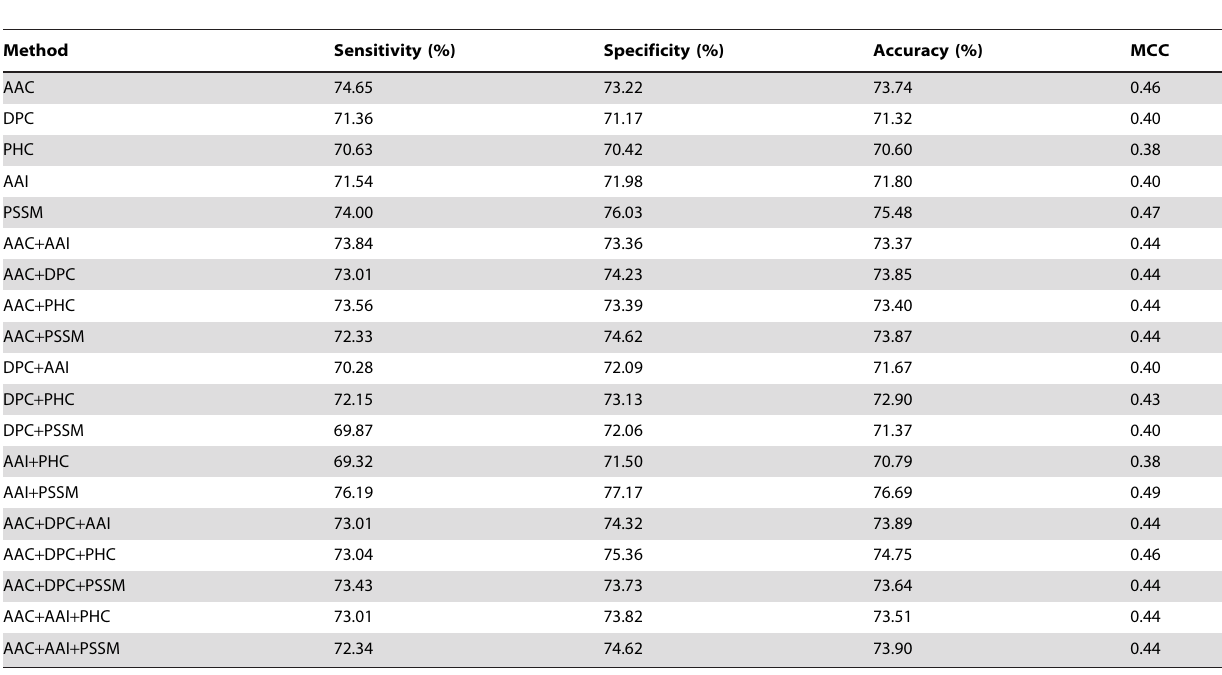
Table 1. The average sensitivity, specificity, accuracy, and MCC for all seven substrate-specific transporter classes for different